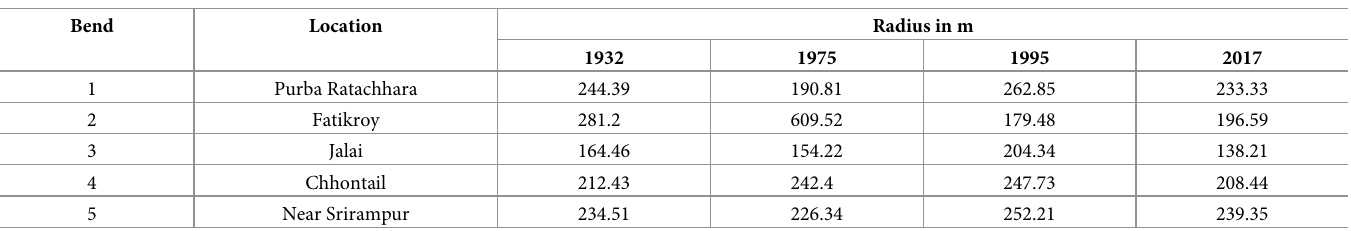
Table 7. Radius of curvature of the selected